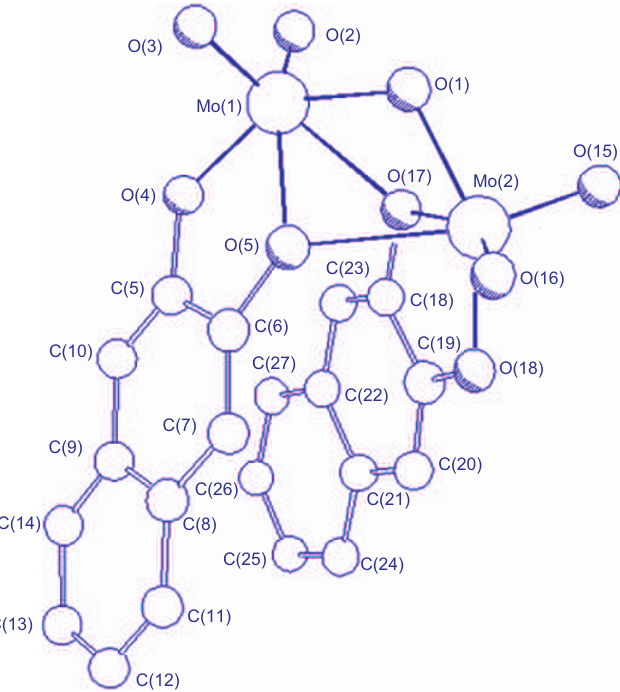
Figure 2 Perspective view of [Mo